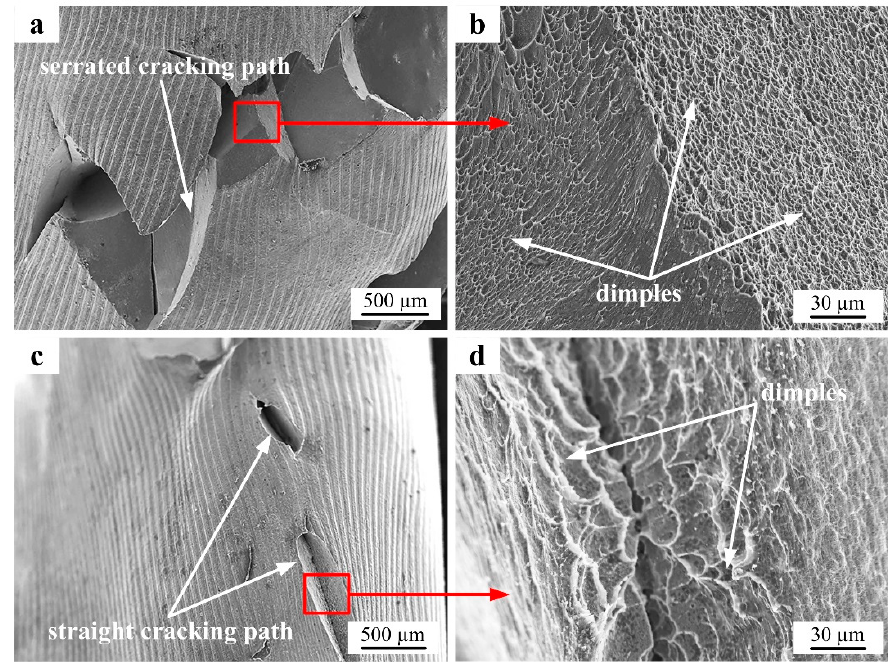
Figure 7. SEM images showing the cracking morphologies of the compressed IM Ti-5553 alloy specimens: ( a , b ) 700 °C/1 s − 1 ; and ( c , d ) 700 °C/0.01 s − 1 .